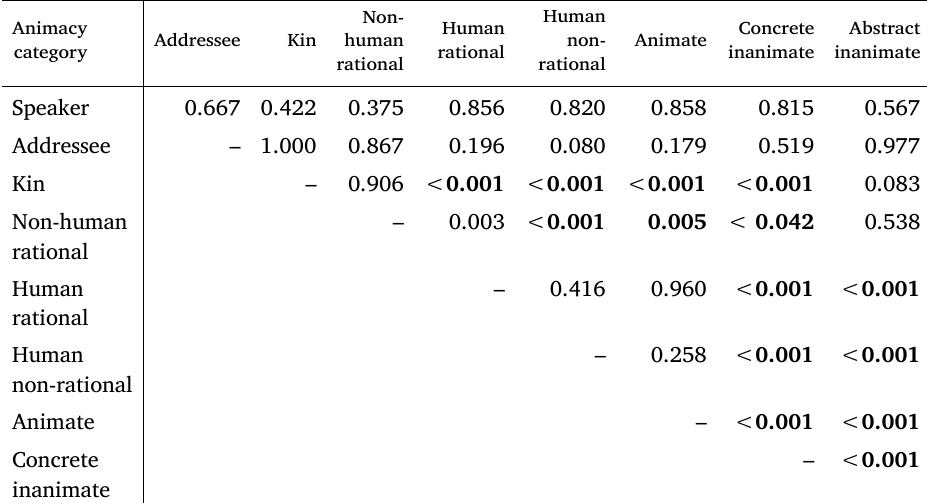
Table 3: Comparison of pairs of groups in the hierarchy Animacy